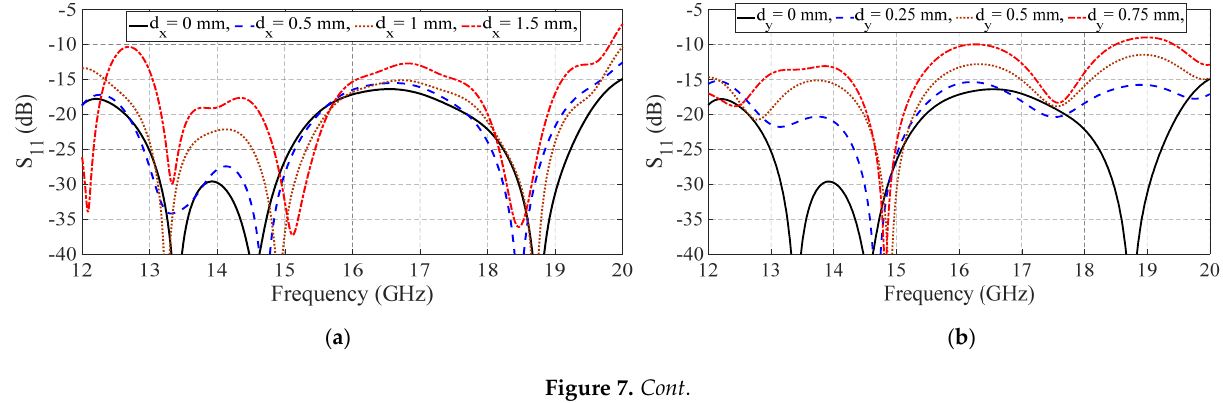
Figure 8. Simulated effects of the sliding part displacement in ( a ) X-axis, ( b ) Y-axis, ( c ) and ( d ) Z-axis on the performance of the switch, and ( e ) bandgap of the pins with ag = 0.3 mm. 4. Fabrication and Measurement The proposed switch was manufactured using aluminum by a standard CNC milling technique in order to verify and test the design performance. Several photographs of the fabricated switch are shown in Figure 9. In order to change the switch state automatically by an electrical signal, a linear actuator was installed on the switch, which consisted of a DC motor and a rack and pinion structure as shown in Figure 9a. The pinion was connected to the motor shaft and engaged to the rack, which was attached to the sliding part of the switch. By clockwise or anticlockwise rotations of the motor shaft, the rack was moved to the right side or left side, and consequently, the switch state could be changed electrically. The traveling range of the sliding part was restricted by the metallic walls as depicted in Figure 9a. Thus, the motor moved the sliding part as far as possible to place the switch into the anticipated state. By